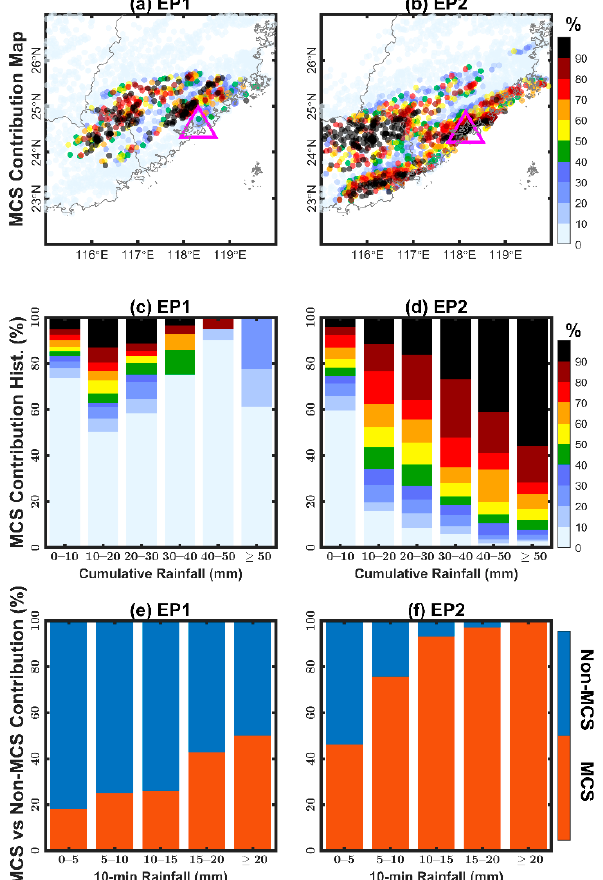
Figure 7. Contribution of MCSs to two successive warm-sector rainfall episodes over southeastern China ( a , c , e ) between 0500 and 2200 LST on 6 May 2018 (EP1) and ( b , d , f ) between 0000 and 1700 LST on 7 May 2018 (EP2). Panels ( a , b ) map the MCS contribution to cumulative rainfall, ( c , d ) show the distribution of the MCS contribution as a function of cumulative rainfall via stacked histograms, and ( e , f ) display the MCS contribution versus the non-MCS contribution to different ranges of 10-min rainfall. The magenta triangles in ( a , b ) denote the maximum cumulative rainfall within the region for EP1 and EP2. In ( a , b ), the provincial boundaries are denoted by gray